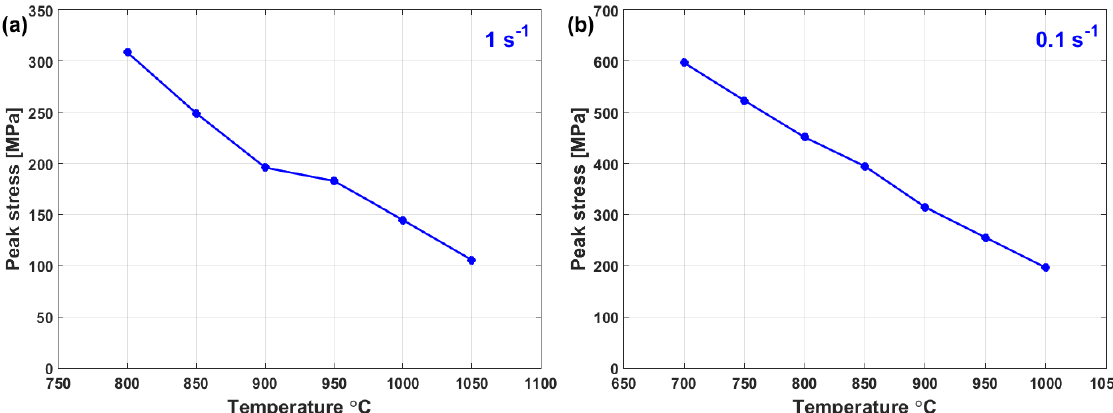
5 of 54 Figure 5. Inverse pole figure maps of microstructures using the EBSD technique on GH690 superalloy at 1000 °C and a true strain of 0.7 for ( a ) 0.001 s −1 , ( b ) 0.1 s −1 , and ( c ) 5 s −1 [136]. 2.2. Effect of Temperature Figure 6 shows peak stress vs. temperature for Fe-26Mn-6.2Al-0.05C steel alloy [124]